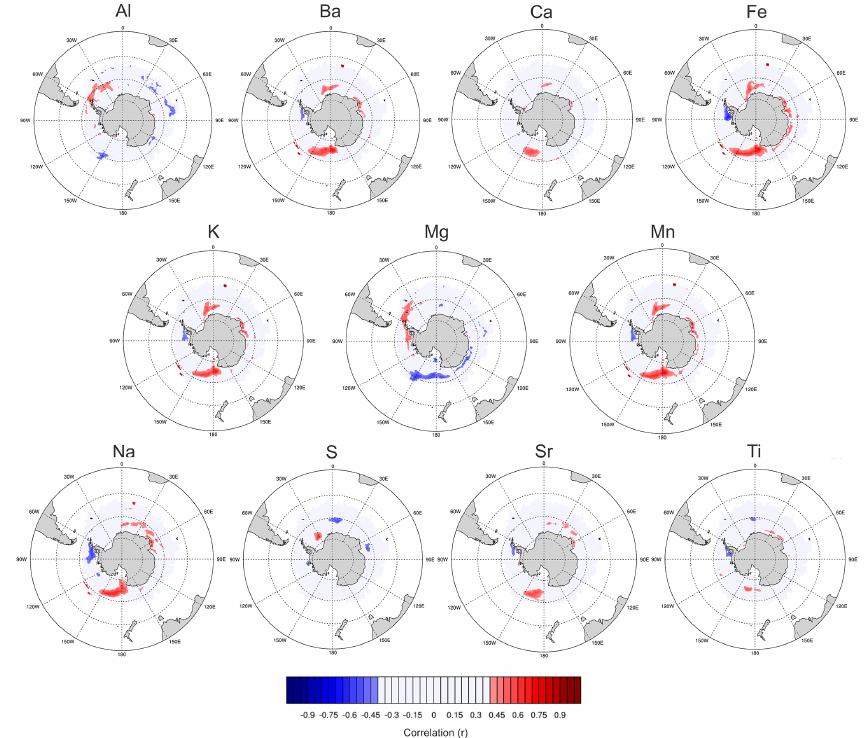
Figure 5. Correlation of the 1979–2008 ERA-Interim reanalysis sea ice concentration with the annually averaged trace element time series in the MJ ice